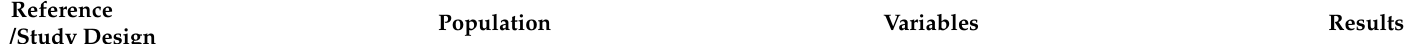
Table 3. Data extraction table detailing the population, variables, and research results of included